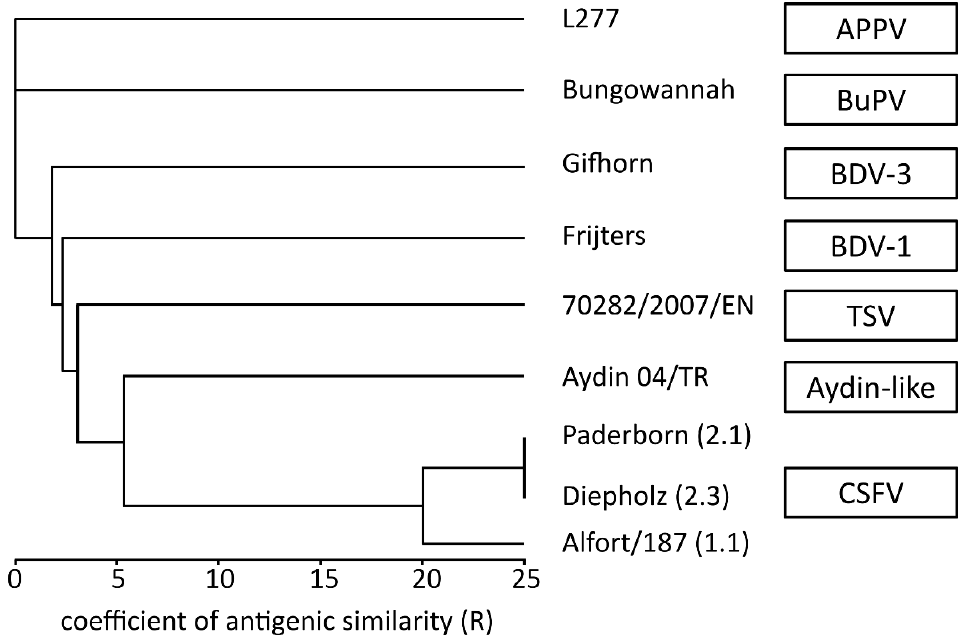
Figure 4. Antigenic relatedness of pestiviruses, including Tunisian sheep-like virus (TSV, isolate 7082/2007/EN), the two border disease virus (BDV) strains Frijters and Gifhorn, classical swine fever virus (CSFV) strains Alfort/187, Paderborn and Diepholz, Aydin virus (isolate Aydin 04/TR) as well as Bungowannah pestivirus (BuPV), and atypical porcine pestivirus (APPV) isolate 277. The antigenic tree based on coefficients of antigenic similarity ( R ). R values ≤ 25 represent significant differences ( ≥ 4-fold) in titers of homologous and heterologous antisera. R values of >25 are not drawn to scale.